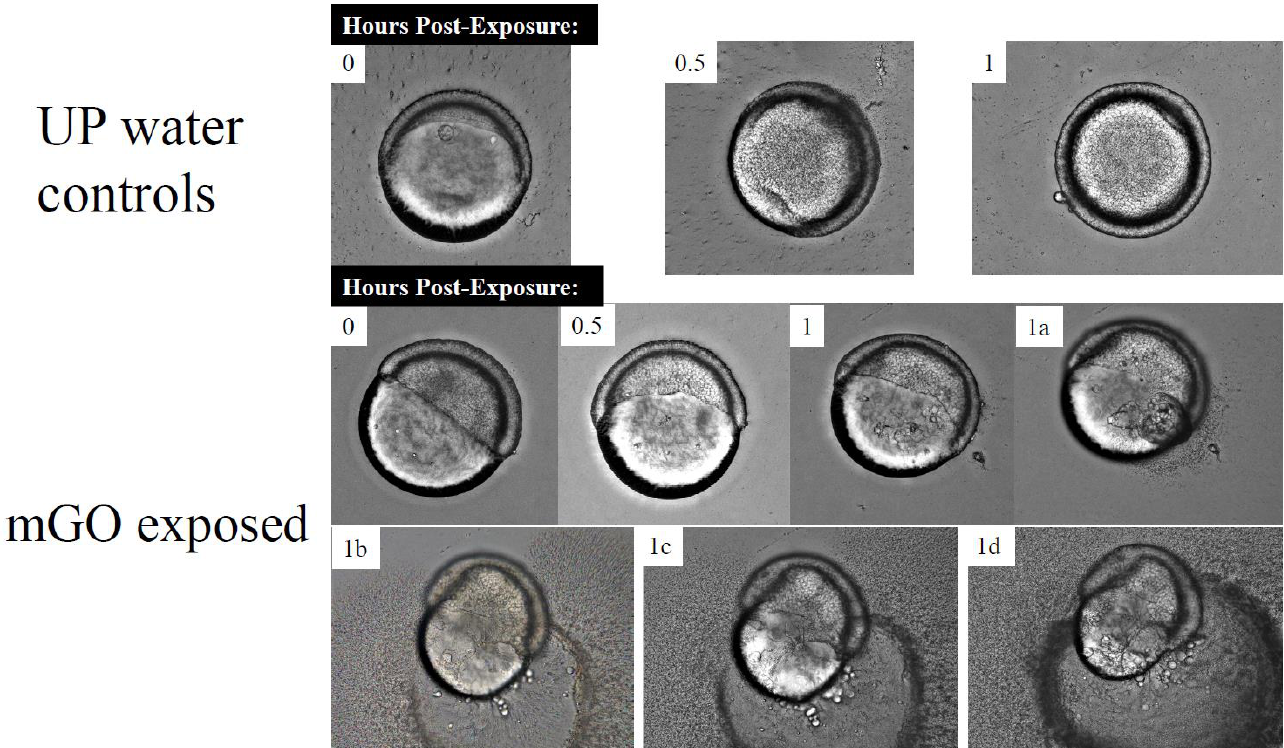
Figure 6. Brightfield imaging of 6 hpf embryos exposed to mGO. The 50 μ g/mL-mGO-exposed and UP water control embryos imaged for 1 h after initial exposure at 6 hpf. Images were taken on BZ-X700 Keyence microscope in a flat-bottom 96-well plate. Images 1a, 1b, 1c, and 1d in the mGO-exposed images were taken in sequential order several minutes apart after the 1 h post-exposure timepoint.